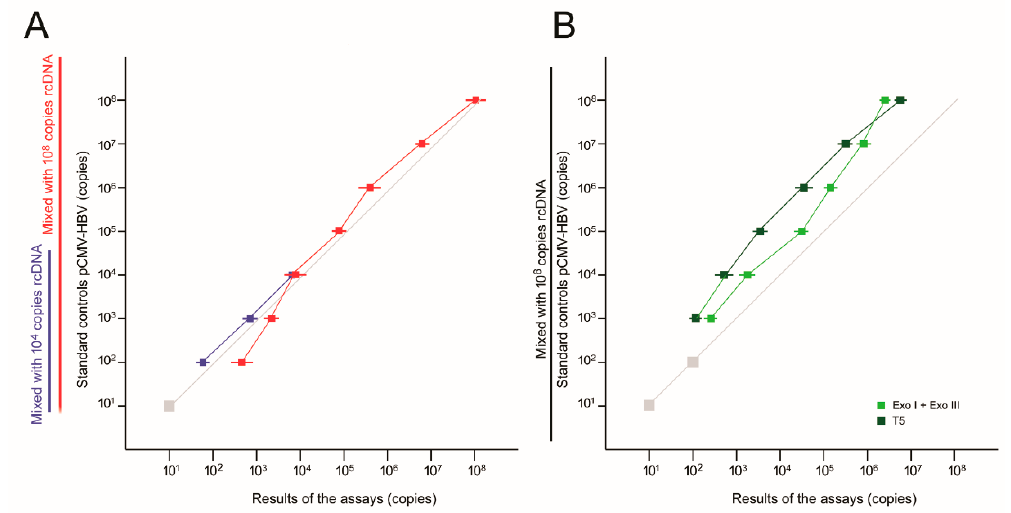
Figure 2. Comparison between the exonuclease based cccDNA assays and the PNA-clamping method. A total of 10 8 copies of rcDNA were mixed with a series of cccDNA mimics (10 1 to 10 8 copies of pCMV-HBV, see Methods) for cccDNA quantification assays. ( A ) The PNA-clamping based assay was performed. Red lines and squares, mixed with 10 8 copies rcDNA; blue lines and squares, mixed with 10 4 rcDNA. ( B ) Exonuclease-based assays. Dark green lines and squares, T5 nuclease assay; light green lines and squares, exonuclease I and II assay. Gray line, the expected accurate results. Gray squares, undetectable concentrations. Three independent assays were performed for each concentration. Short horizontal lines, standard deviation.